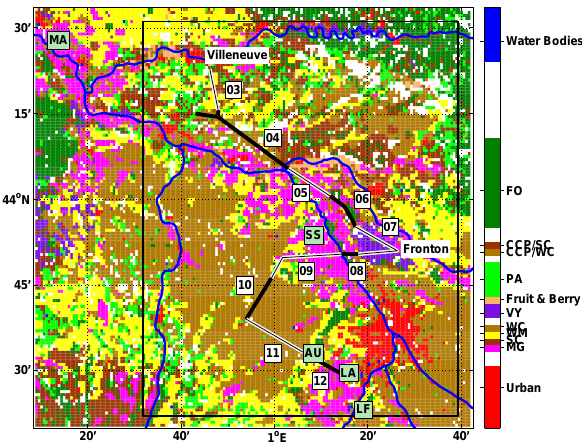
Fig. 2. Flight domain with two schematic flight tracks divided into 12 segments (B/W) and ground flux sites (2-character labels; see text for abbreviations) in the direct vicinity. Rectangular box depicts the extracted domain area of land use for reference with regard to land-use distribution for segment 3 to 12 (see